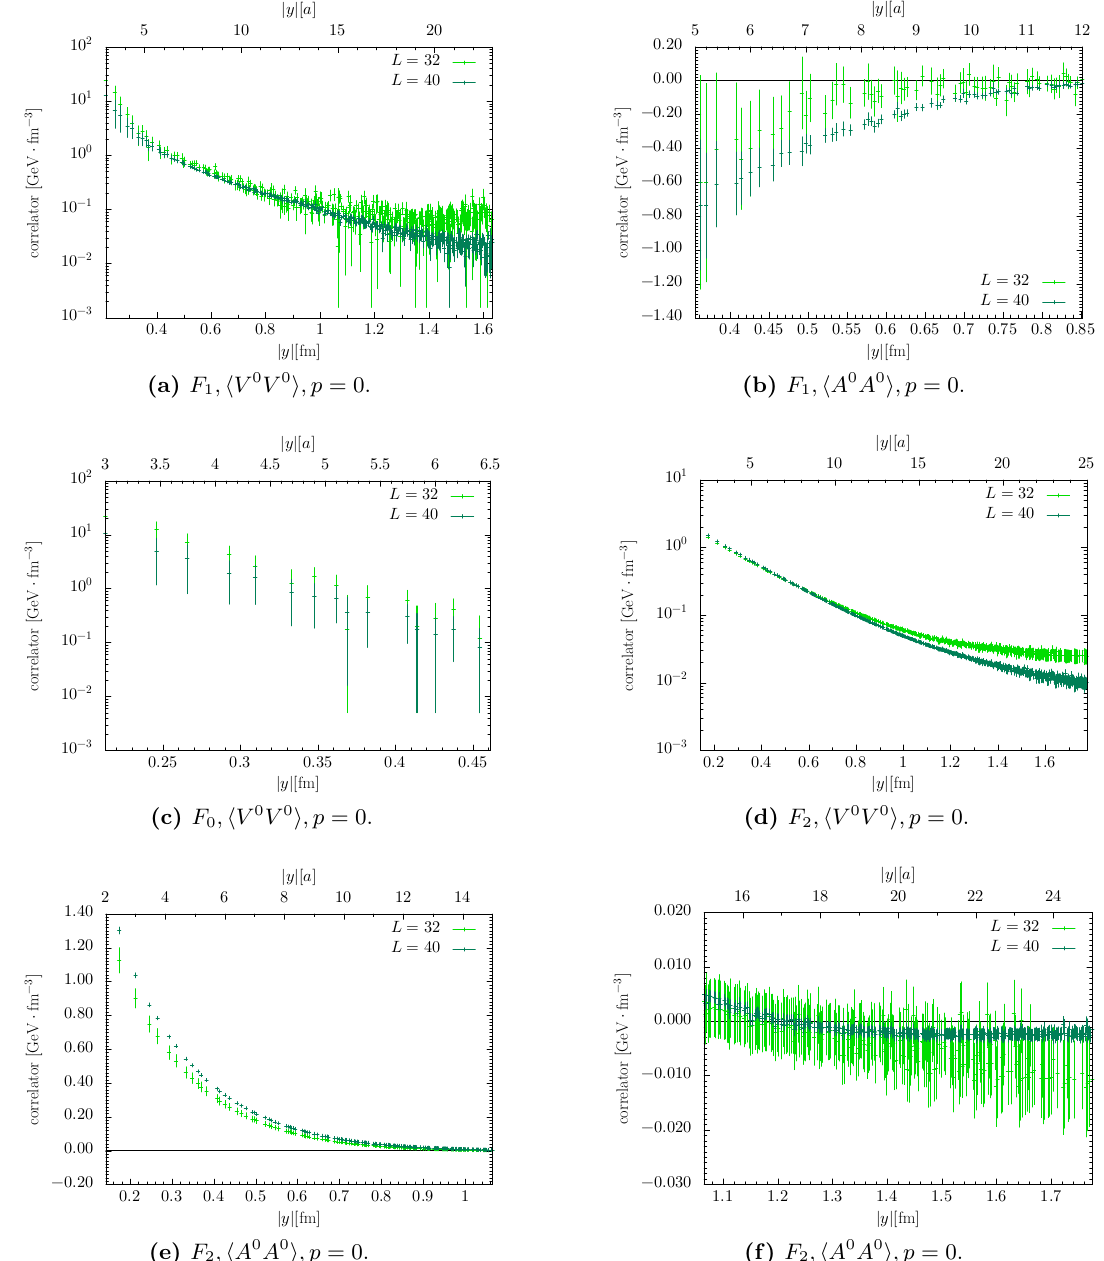
Figure 20. Lattice results for isospin amplitudes of F 0 has very large statistical errors and is not